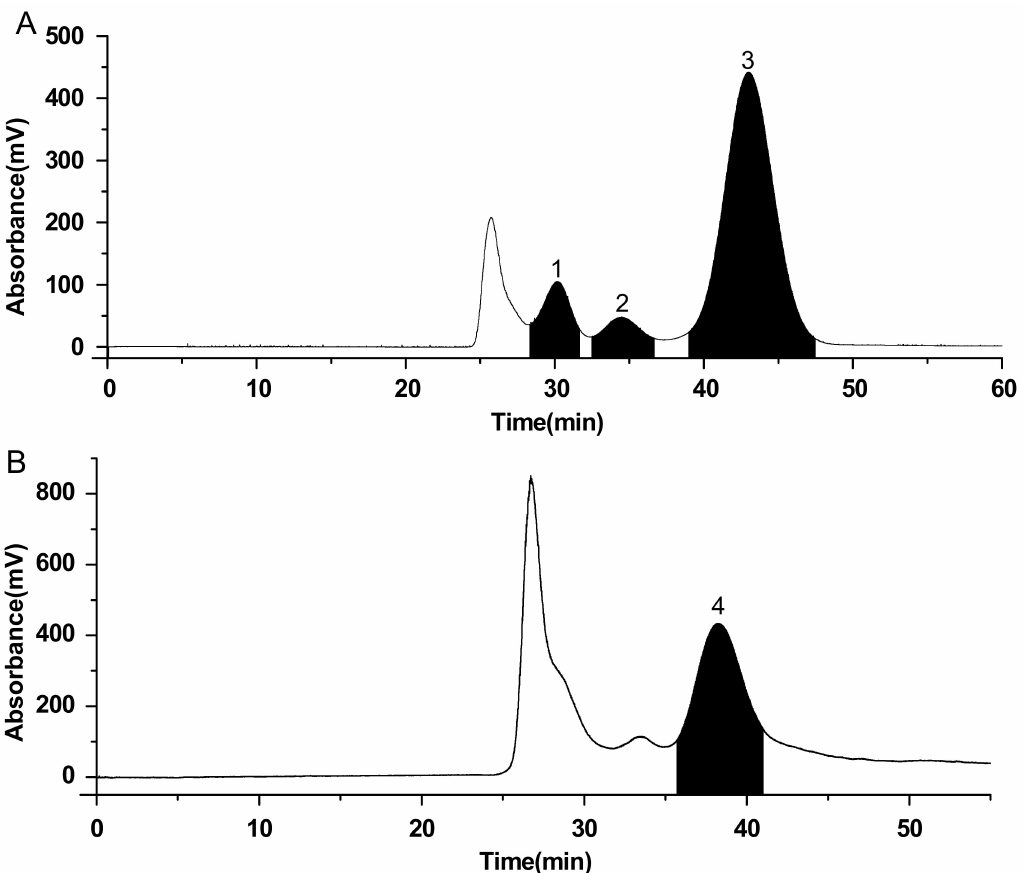
Figure 1. HSCCC separation chromatograms of samples obtained from Gentianae radix . ( A ) Sample 1, ethyl acetate– n -butanol–water (2:1:3, v / v / v ); and ( B ) Sample 2, hexane–ethyl acetate–methanol–water (1:3:1:3, v / v / v / v ); sample size = 100 mg; flow rate = 5 mL/min; detection wavelength = 254 nm; revolution speed = 800